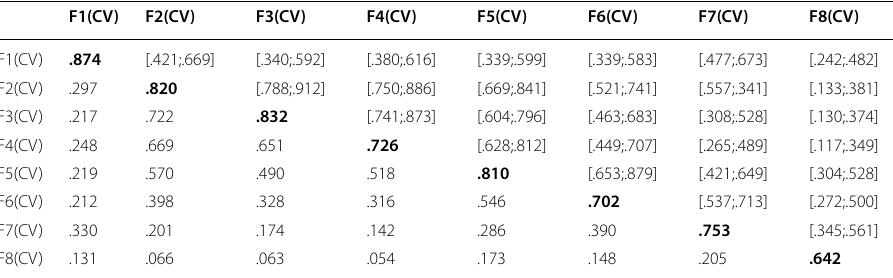
The diagonal represents the AVE; above the diagonal, the 95% confidence interval for the estimated factor correlations is provided; below the diagonal, the shared variance (squared correlations) is